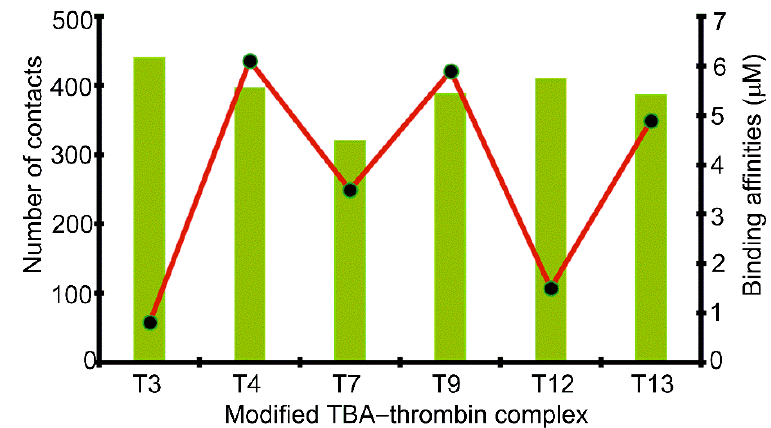
Figure 7. Total number of contacts at the DNA–protein interface in the modified TBA–thrombin complexes. Experimental binding affinities of the TBA – thrombin complexes are indicated by the black dots.